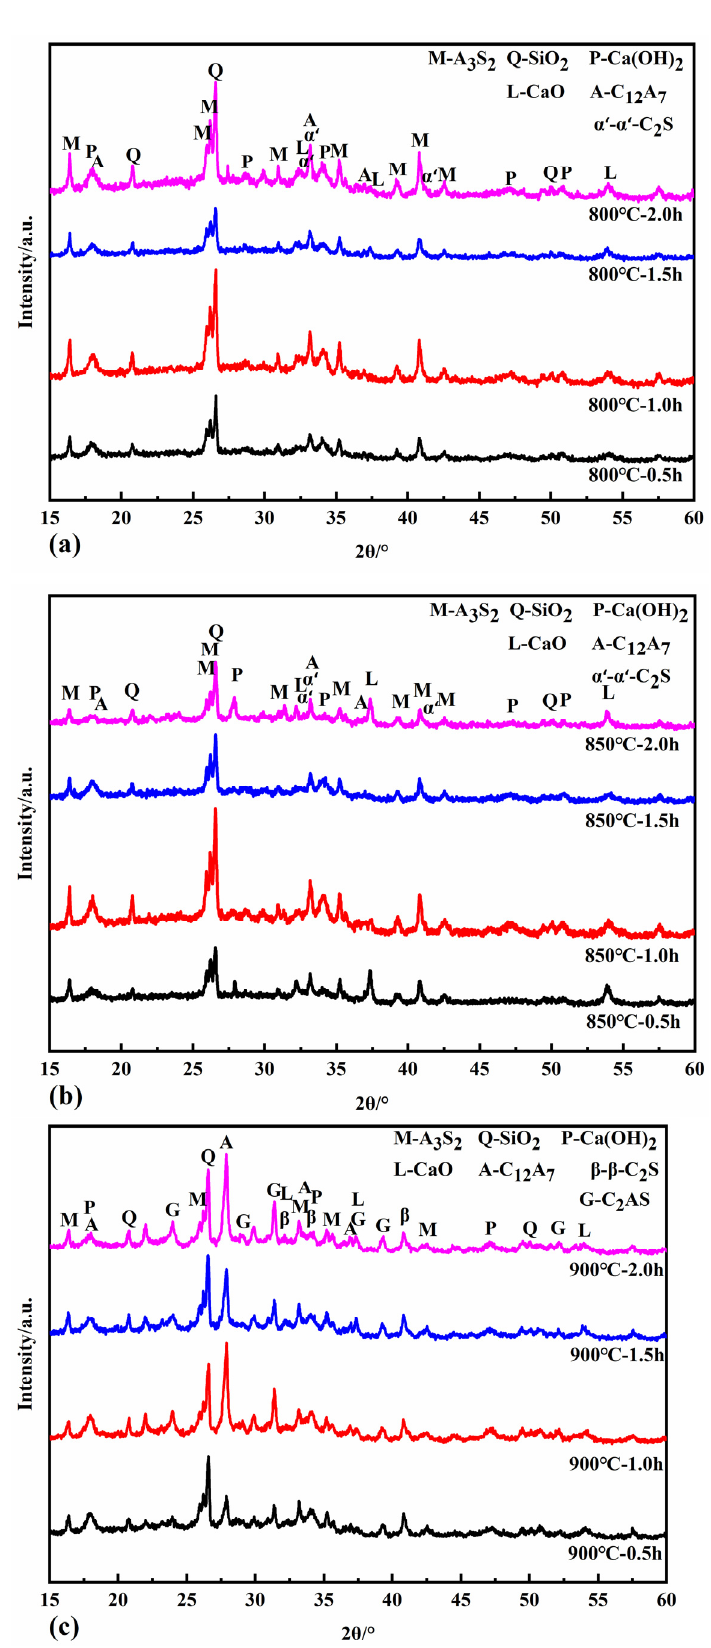
◦ C ( a ), 850 ◦ C ( b ), and 900 ◦ C ( c